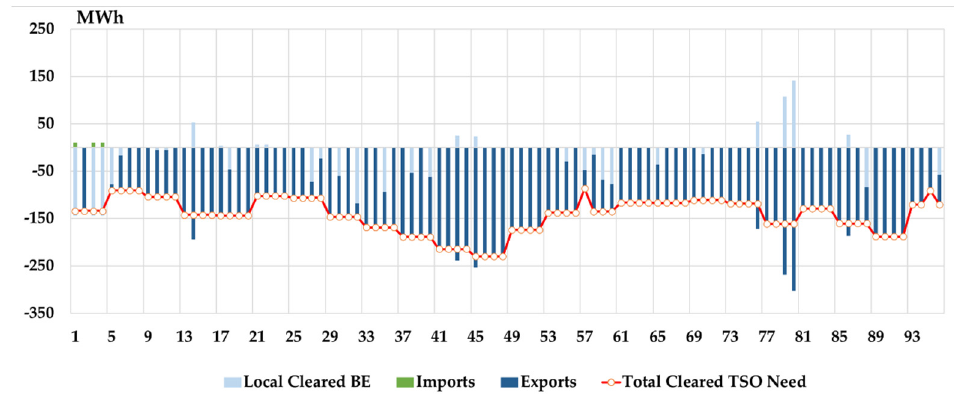
Figure 20. Power balance and cleared mFRR BE quantities per RTU for Portugal.